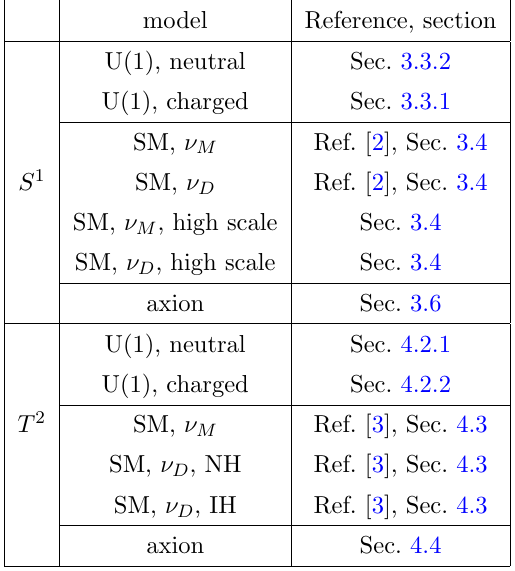
Table 1 . The models which will be analyzed in this paper. Related earlier works are also